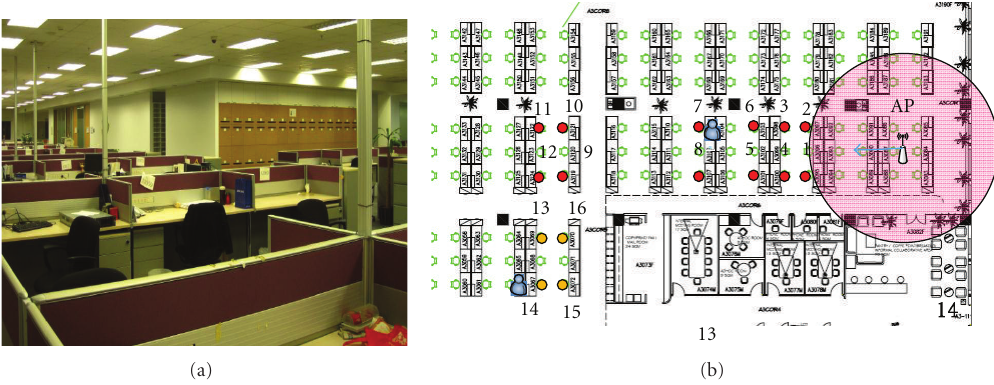
Figure 4: Measurement environment and route plan: (a) measurement environment; (b) route plan.